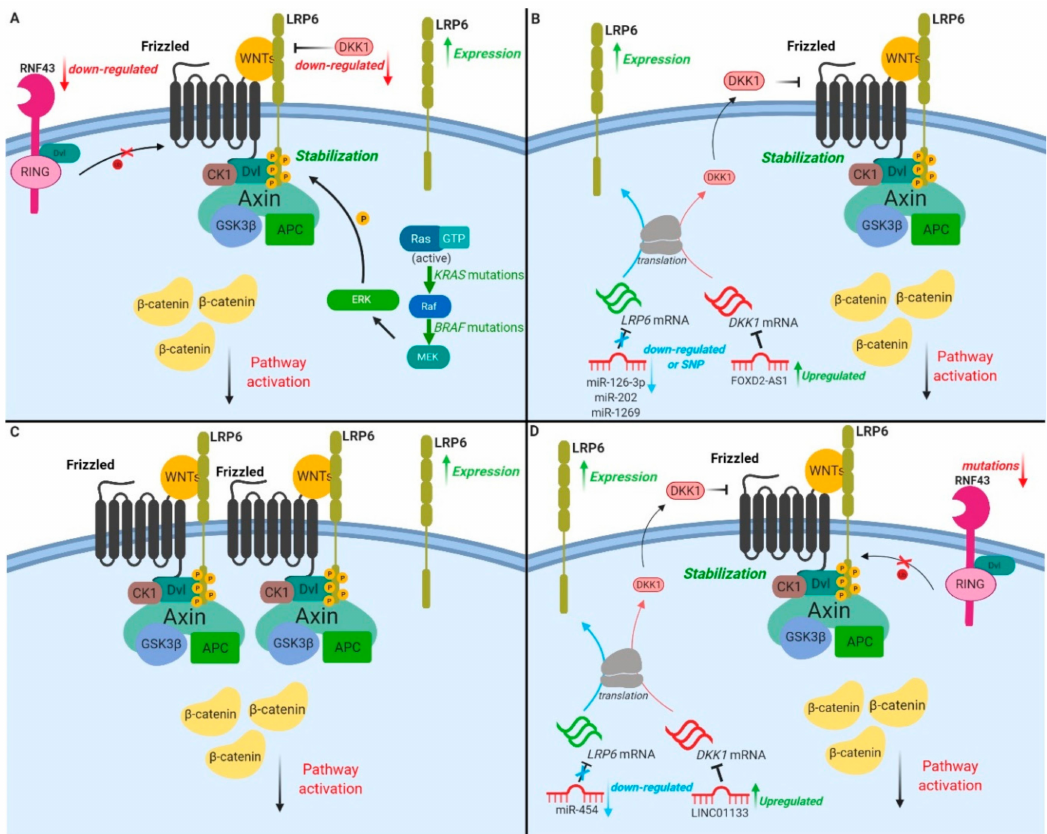
Figure 3. LRP6 and WNT / β -catenin pathway alterations in epithelial cancers. ( A ) In colorectal cancer (CRC), LRP6 overexpression is observed in 61% of malignant tissues isolated from patients. (i) Mutations in the E3 ubiquitin-protein ligase RNF43, (ii) downregulation of the antagonist